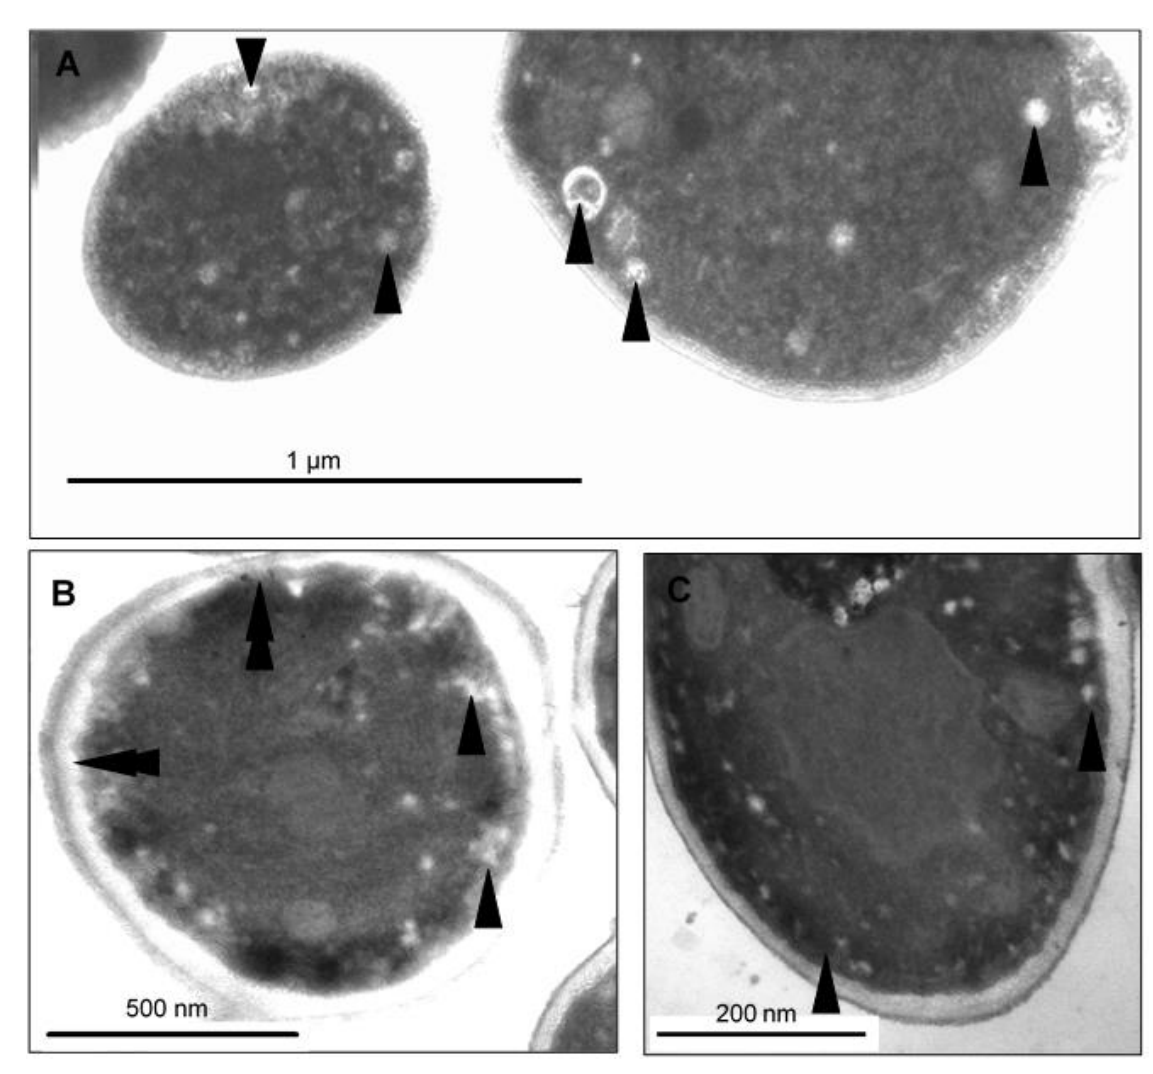
Figure 9. TEM micrographs of C. glabrata SZMC 1374 treated with a sub-lethal concentration of CAPE. ( A – C ) Mainly smaller necrotic signs were detected. Arrowheads denote small, mainly peripheral vacuoles typical of all samples. ( B ) Cell wall disintegration was also observed (double arrowhead).